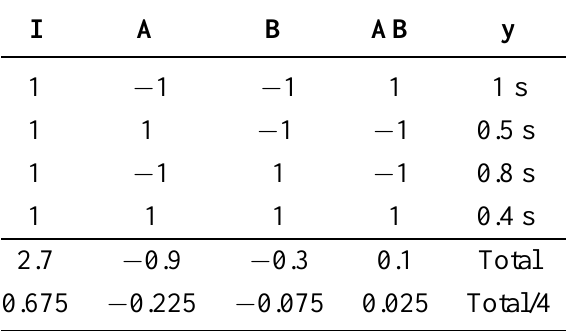
Table 3. Sign table method of calculating the effects of the factors in a 2 2